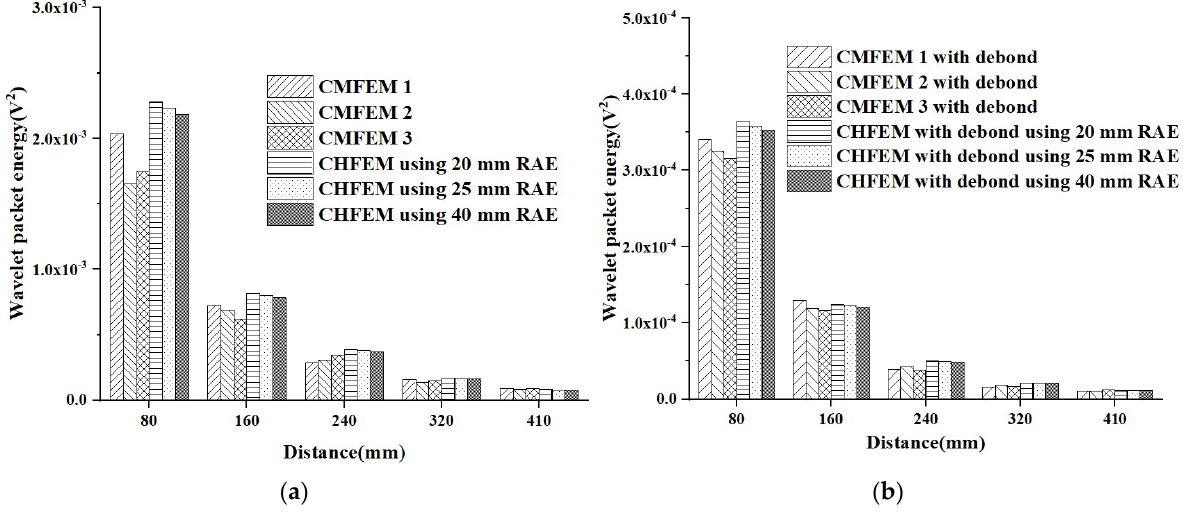
Figure 16. Comparison of wavelet packet energy value of response of PZT sensors between CMFEMs and CHFEMs corresponding to CMFEM 1 with different RAE sizes under modulated sinusoidal signals. ( a ) Healthy CMFEMs and CHFEMs; ( b ) CMFEMs and CHFEMs with interface debond defects.